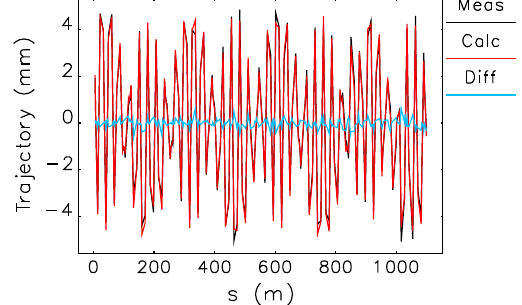
FIG. 3. Comparison of the measured and calculated first-turn trajectory after the difference was minimized by adjusting the kicker calibration.